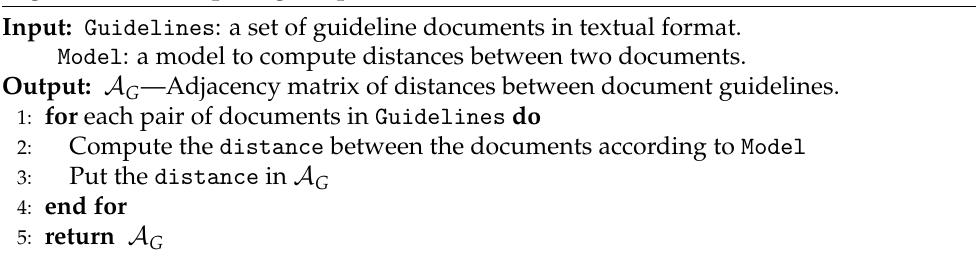
Algorithm 1 Computing Graph of Distances Between